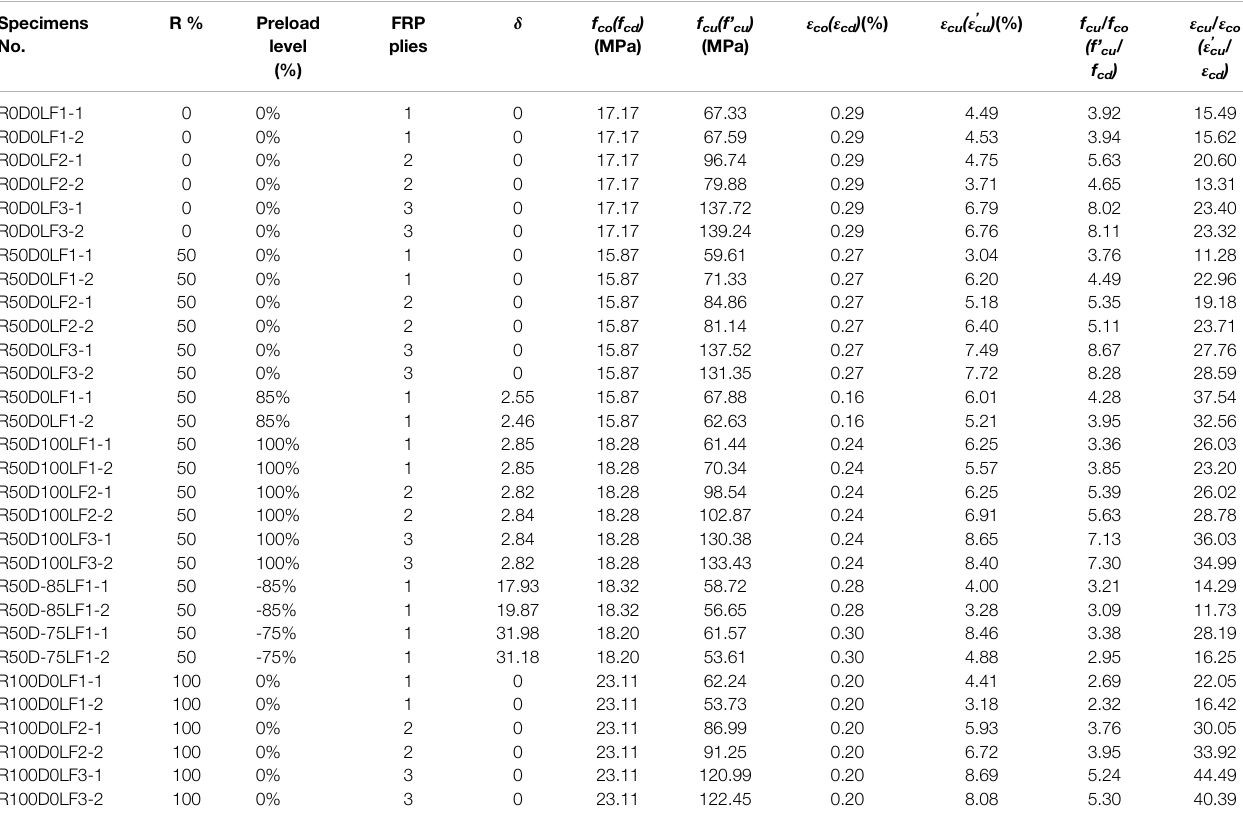
TABLE 8 | Test results for LRS FRP con fi ned specimens Specimens